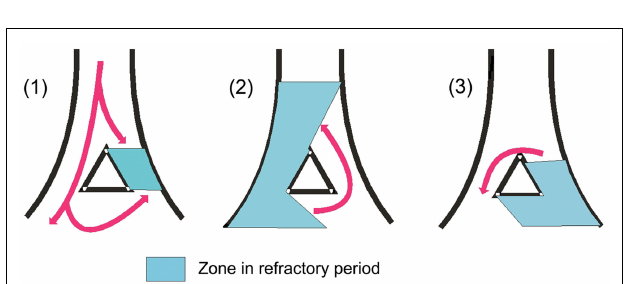
FIGURE 3 | Reentry arrhythmias. They affect a restricted area (micro-reentry) or a large area (macro-reentry) of the myocardium.When the excitation wave goes down the intra-cardiac system that is blocked by an area in refractory period (A) , it travels around and may excite it in a retrograde direction (the abnormal zone meanwhile comes out of its refractory period, see ( B) .Then, the wave having reached the initial blockade point can, this time, travel in the normal direction (anterograde) to neighbor non-refractory fibers and cause a new premature contraction (C) . This can originate an excitation wave rotating within a closed circle and that may propagate to adjacent myocardial tissues. NB: An identical phenomenon may occur in cases of myocardial ischemia, with a slowing down of intra-ventricular conduction in the ischemic area.The excitation wave reaches tissue that is no longer in refractory period and can travel in reverse direction, and thus, may cause reentry arrhythmias.